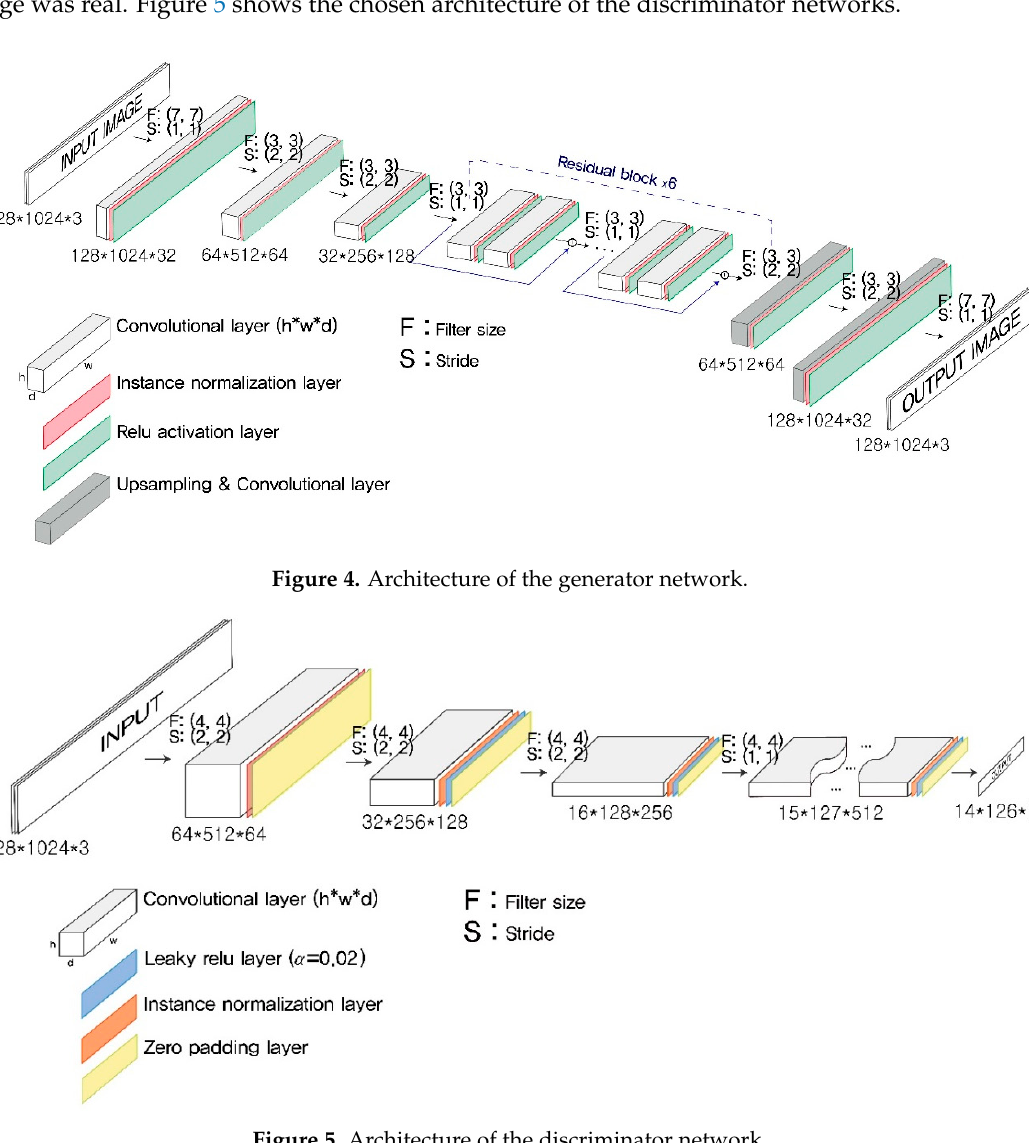
Figure 5. Architecture of the discriminator network.